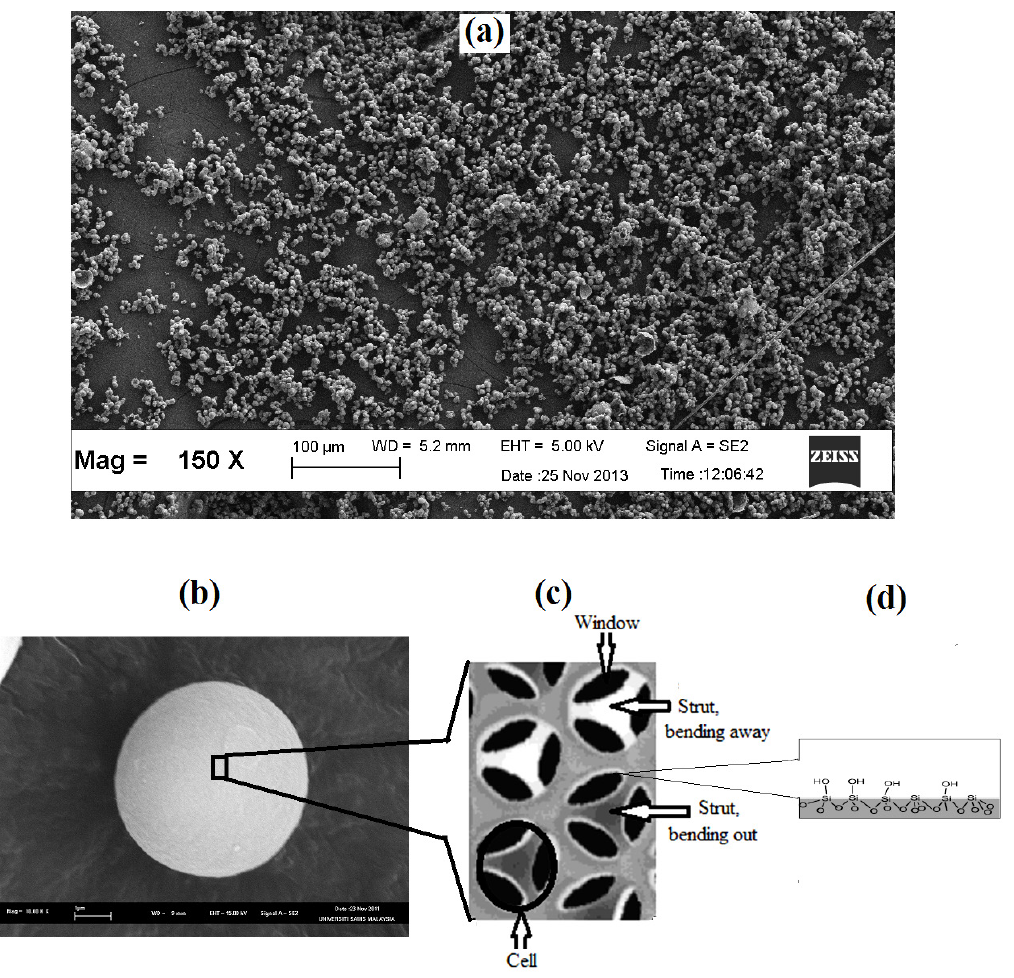
Figure 1: SEM image of (a) spherical MCF silica particles; (b) a single spherical MCF particle at higher magnification; (c) Schematic cross section of the structure exhibited by MCF silica; (d) Silanol groups ( ≡ Si - OH ) on wall of MCF silica.